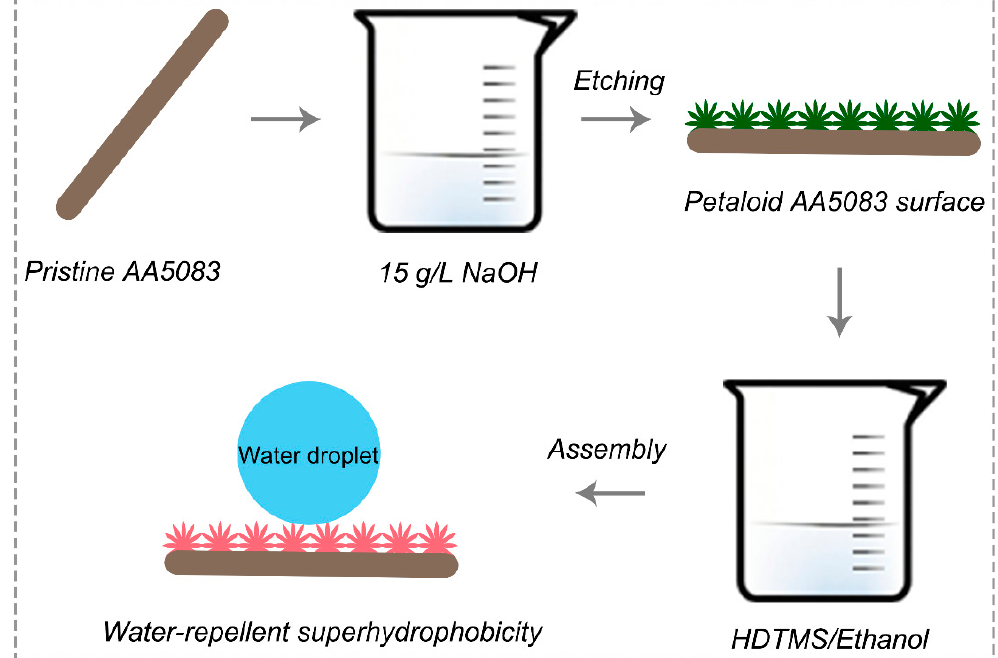
Figure 1. Schematic illustration of the fabrication process.